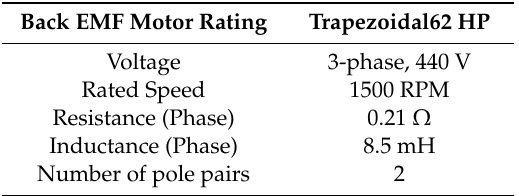
Table 4. Brushless direct current (BLDC) motor